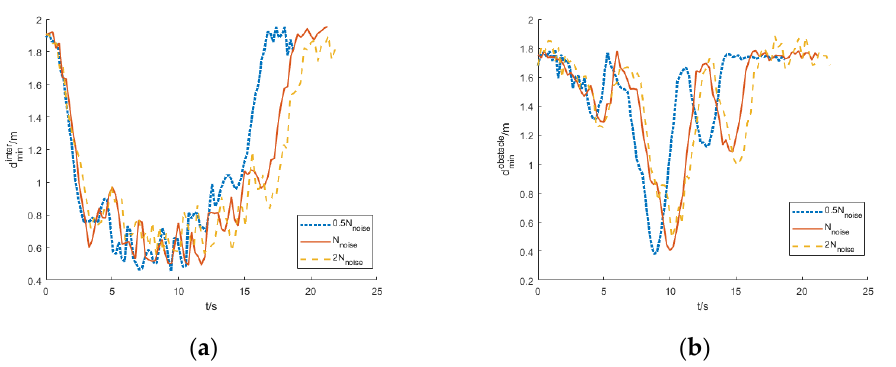
Figure 9. Comparison of minimum distance under different level disturbances, ( a ) the minimum distance between robots, ( b ) the minimum distance between robot and obstacle.